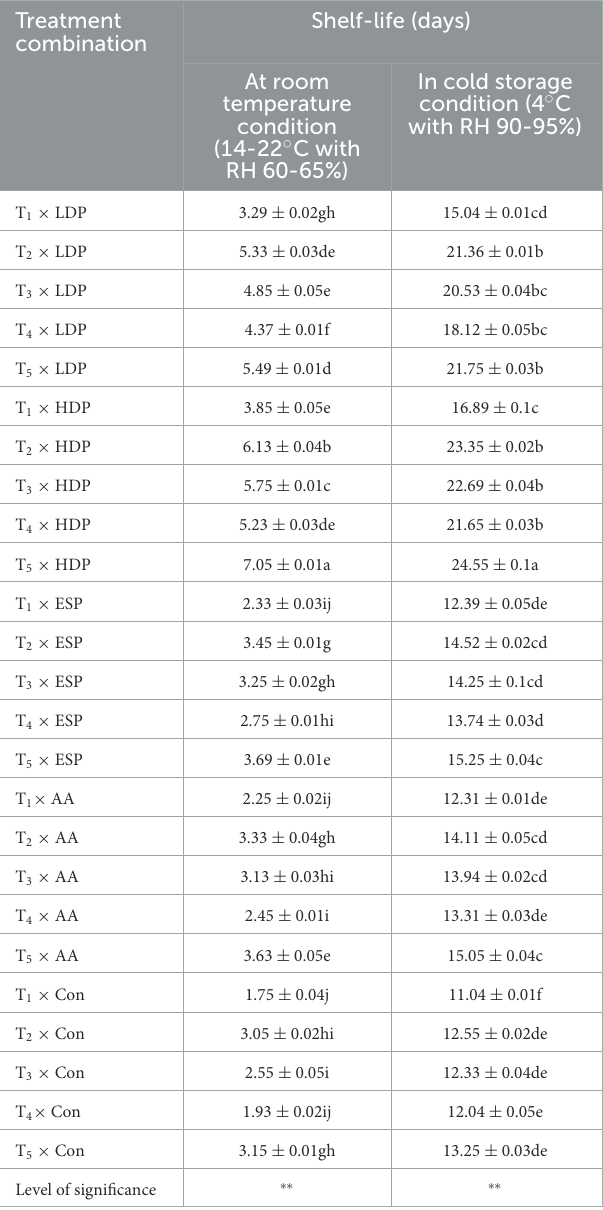
TABLE 3 Influence of pre-harvest foliar application of mineral nutrients and post-harvest packaging and chemical treatments on shelf-life of broccoli under different storage